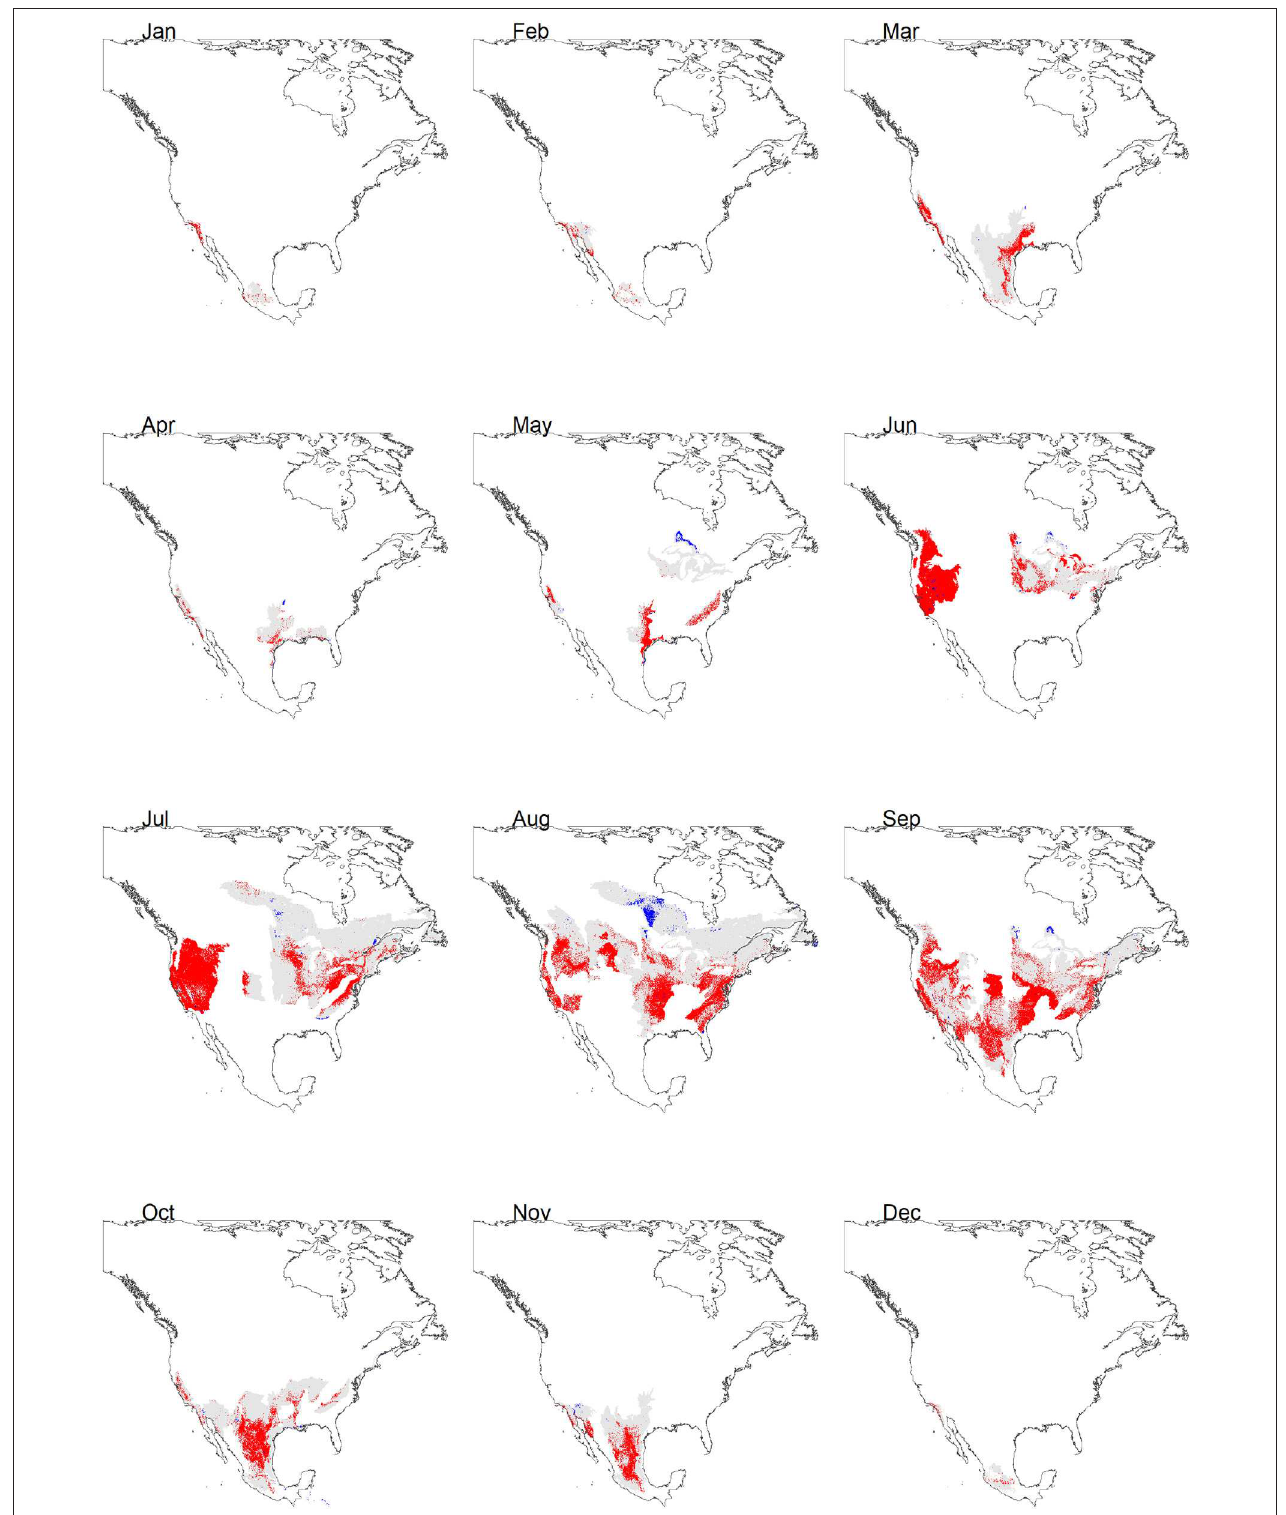
FIGURE 3 | Continuous (gray areas) and discrete (red areas) suitability projections by month of the monarch butterfly migratory route. Blue areas indicate zones where model extrapolation occurs.